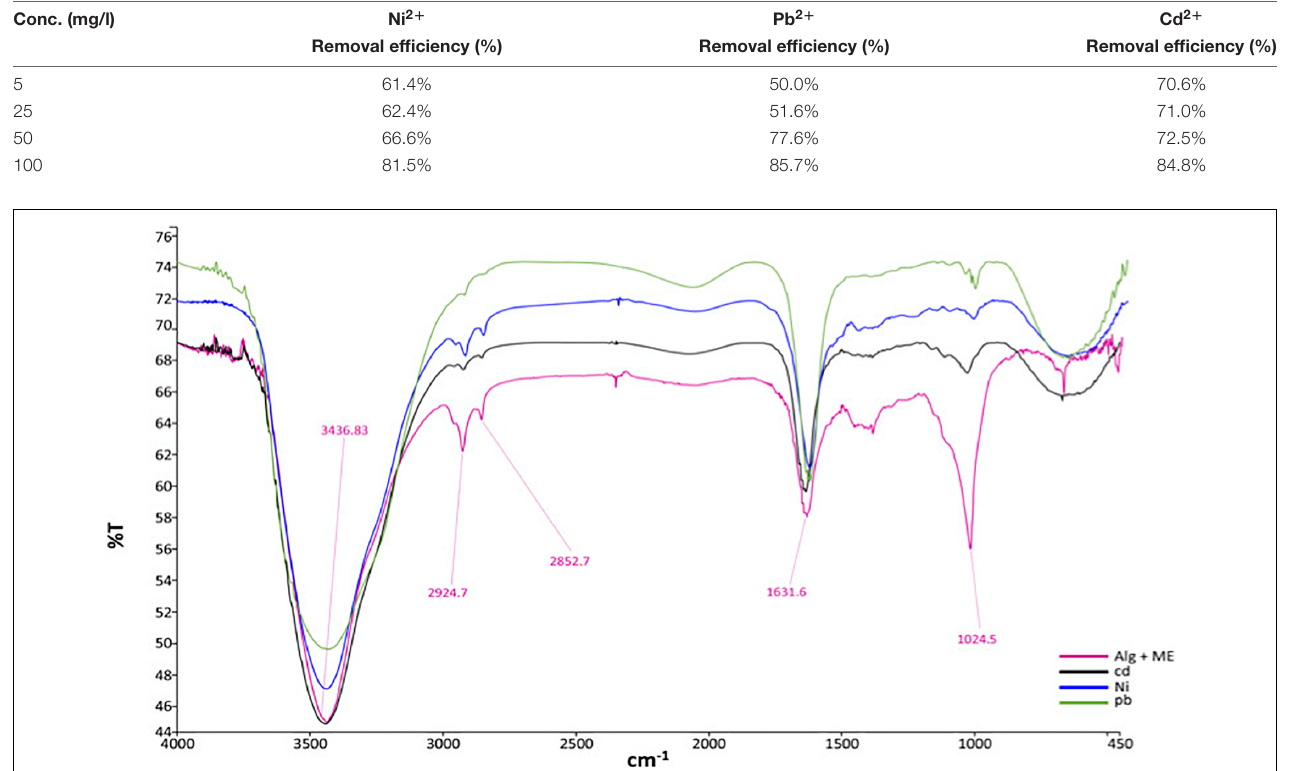
FIGURE 5 | FTIR spectra of (pink) alginate entrapped melanin, (blue) nickel-bound melanin, (black) cadmium-bound melanin, and (green) lead-bound